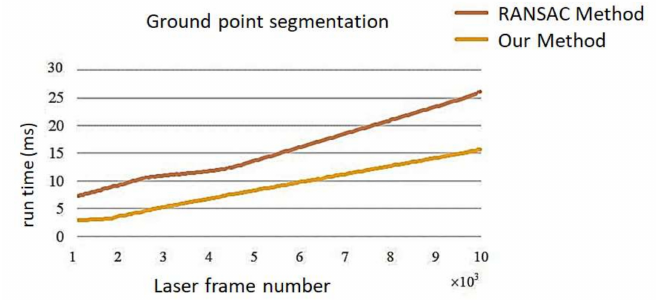
Figure 6. Comparison of ground point segmentation speed.